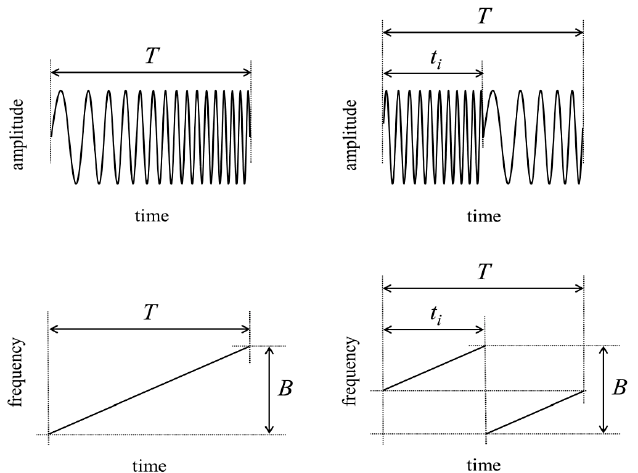
Figure 4. Schematic representation of the pulses ( Top ) and time-frequency diagrams ( Bottom ) for the conventional nonshifted chirp ( Left ) and the cyclically shifted chirp ( Right ) [7]. The sequence of shifts, 𝑡 (cid:3036) , which identifies the sequence of waveforms, is periodically repeated while 𝑇 and 𝐵 remain constant. The pulse-to-pulse variation across the azi- muth is described by the 𝑡 (cid:3036) variation given by the following quadratic law [7]: